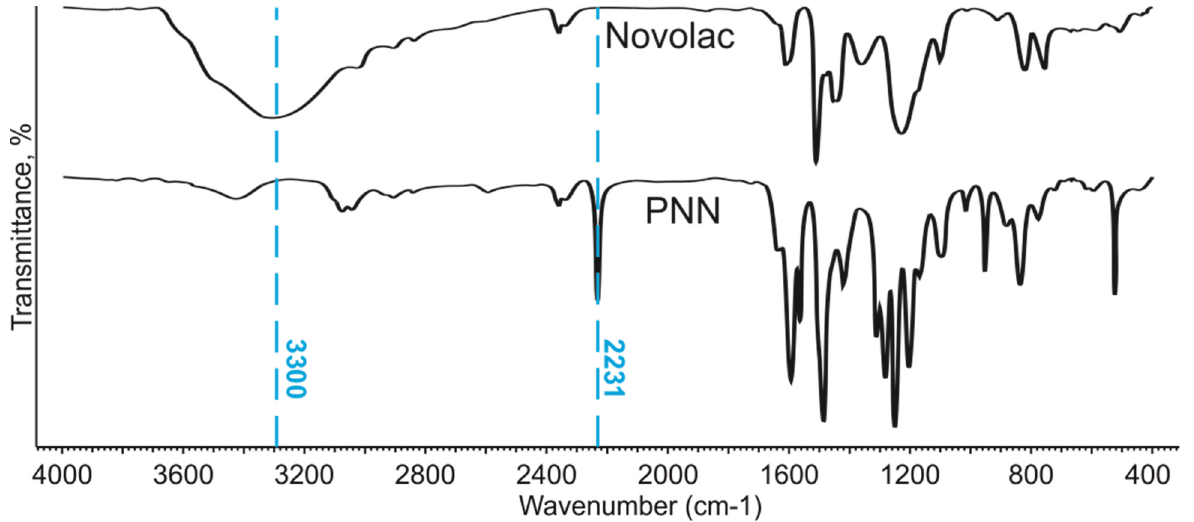
Figure 3. FT-IR of novolac and PNN.